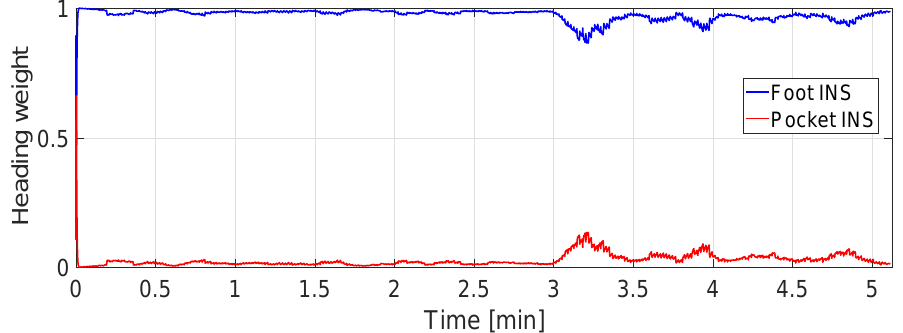
Figure 15. Heading weights estimated for the pocket INS and the foot INS in the walk depicted in Figure